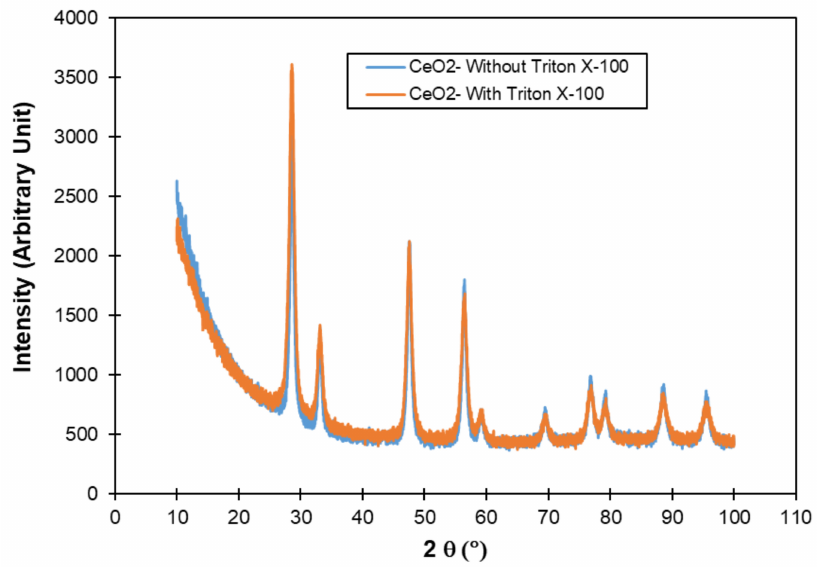
Figure 3. XRD spectra CeO 2 synthesized by hydrothermal method followed by annealing in absence and presence of Triton TM X-100